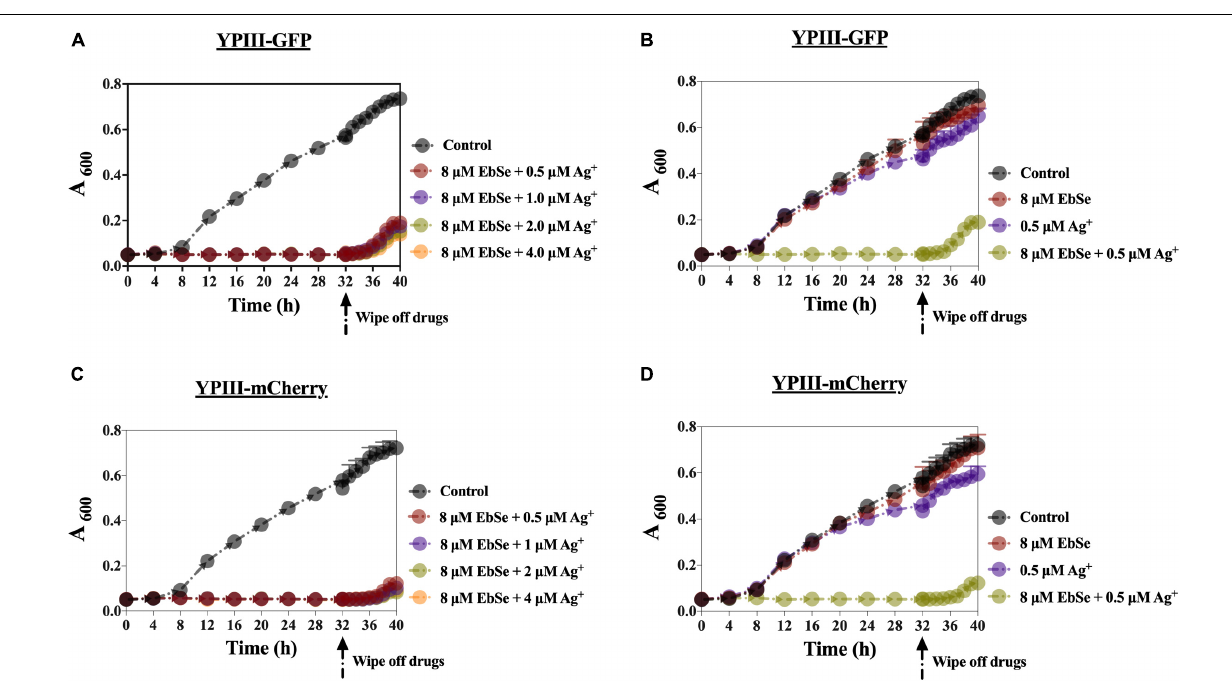
FIGURE 4 | The PAE effect of EbSe-Ag + against YpIII. YpIII-GFP and YpIII-mCherry were cultured to A 600 of 0.4, diluted 1:1,000 times, and treated with EbSe-Ag + . The results showed EbSe-Ag + has a PAE of 4 h. (A,C) 8 µ M EbSe and a serial concentration of Ag + ; (B,D) 8 µ M EbSe and 0.5 µ M Ag + ; (A,B) YpIII-GFP; (C,D)